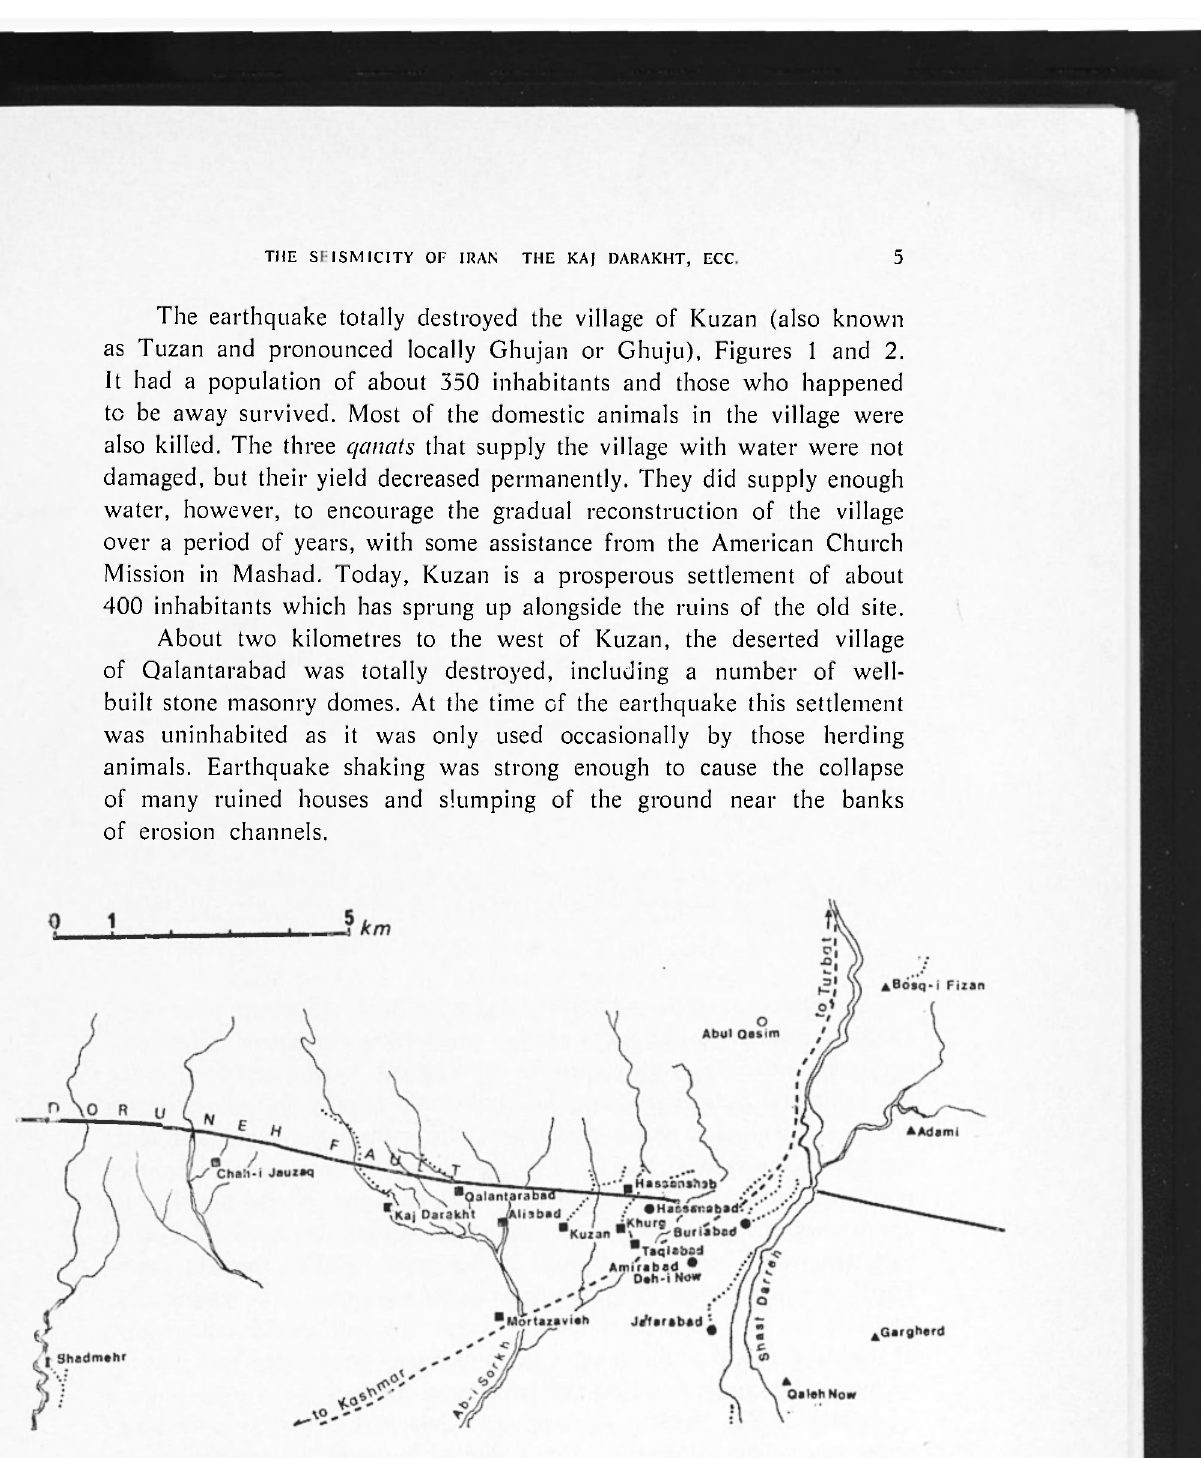
Fig. 1 - Location map of mcizoseismal area of the earthquake of 25th May 1923. For regional location of the event, see Figure I in Ref. (2), Solid squares indicated villages almost totally destroyed with casualties; circles show locations of major damage and triangles, sites seriously damaged. Small dots indicate alignment of major